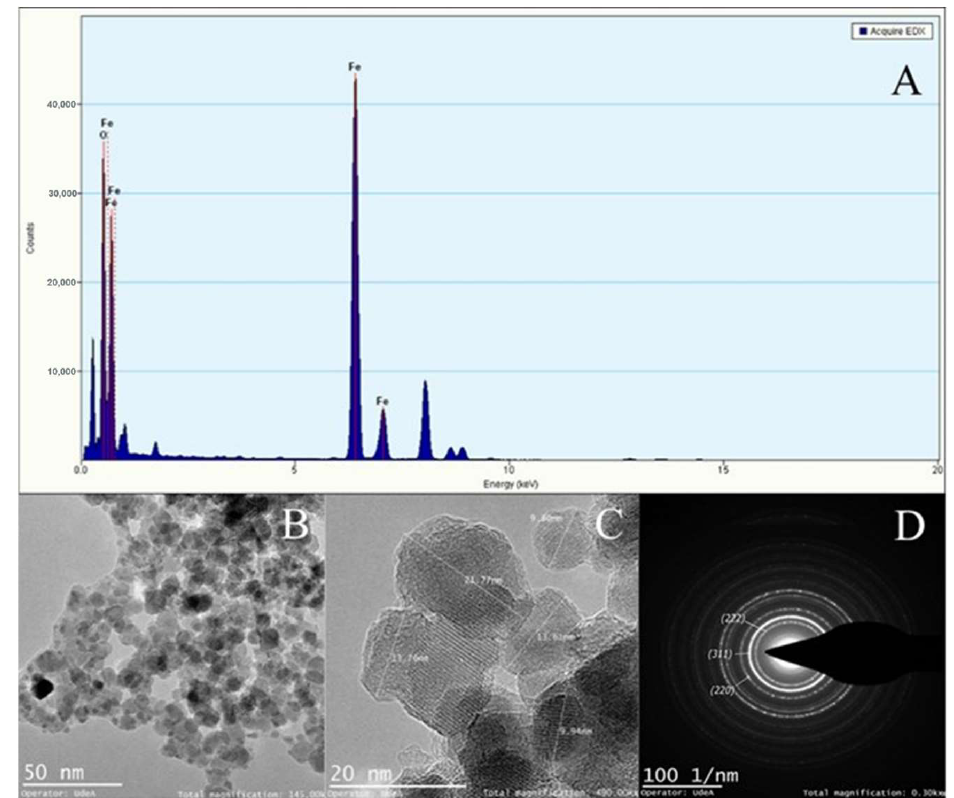
Figure 10. TEM−EDX analysis of magnetite particles manufactured by the TB micromixer. ( A ) Elemental analysis confirmed the abundance of iron. ( B ) Low magnification imaging confirmed the typical morphology of magnetite crystals. ( C) High magnification imaging allowed the calculation of an average particle diameter of 11.96 ± 4.1 nm. ( D ) Selected area electron diffraction with indexed planes that correspond to magnetite crystalline planes.